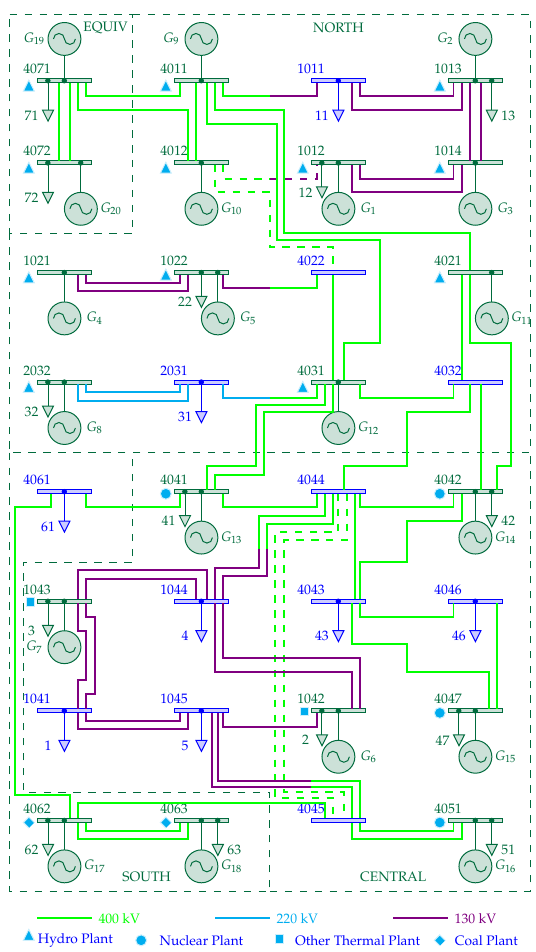
Figure 2. Nordic 32 Bus Test System.